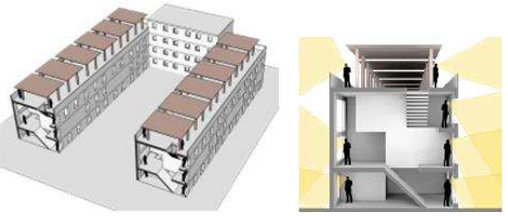
Figure 6. First alternative schematic design: repetitive vertical apartments.